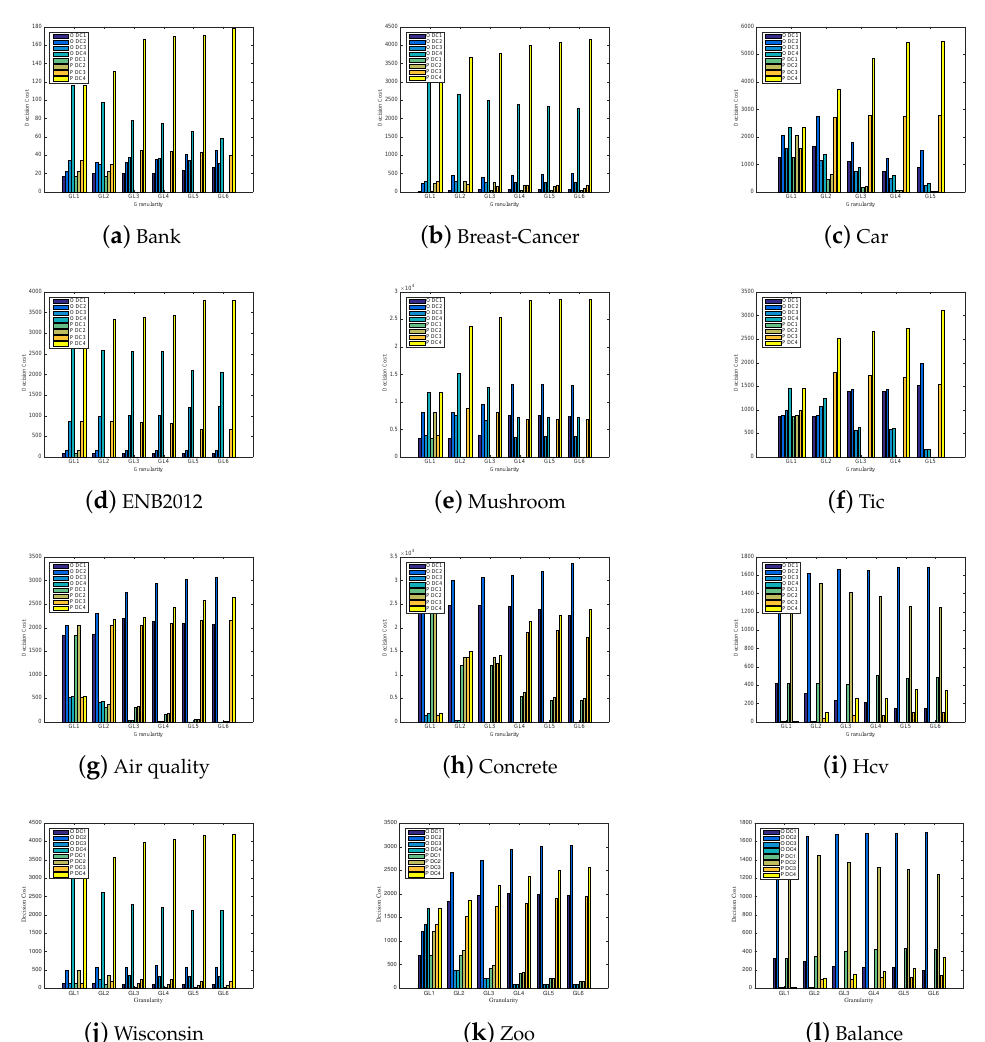
Figure 5. The misclassification cost of two boundary regions under different granularities. In Figure 6, the horizontal and vertical axes denote the granularity and misclassifi- cation costs, respectively. O DC _ lower , O DC _ upper and O DC represent DC (